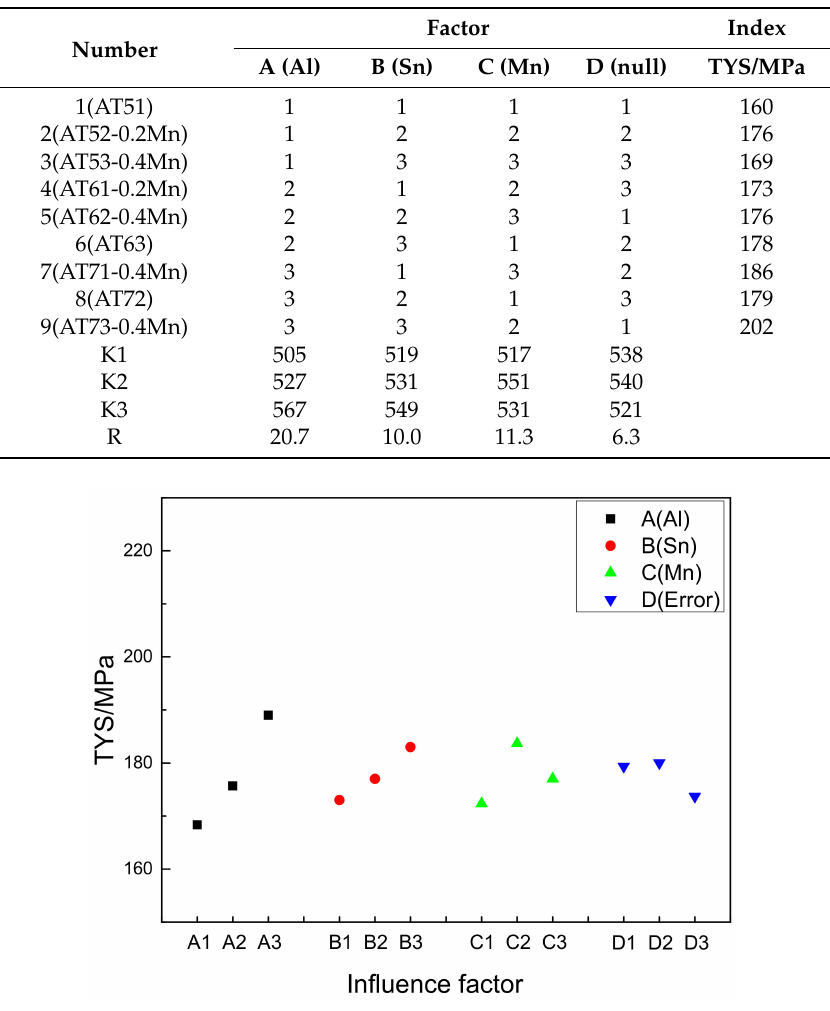
Figure 12. Factors and Index trends diagram of tensile yield strength for nine trial